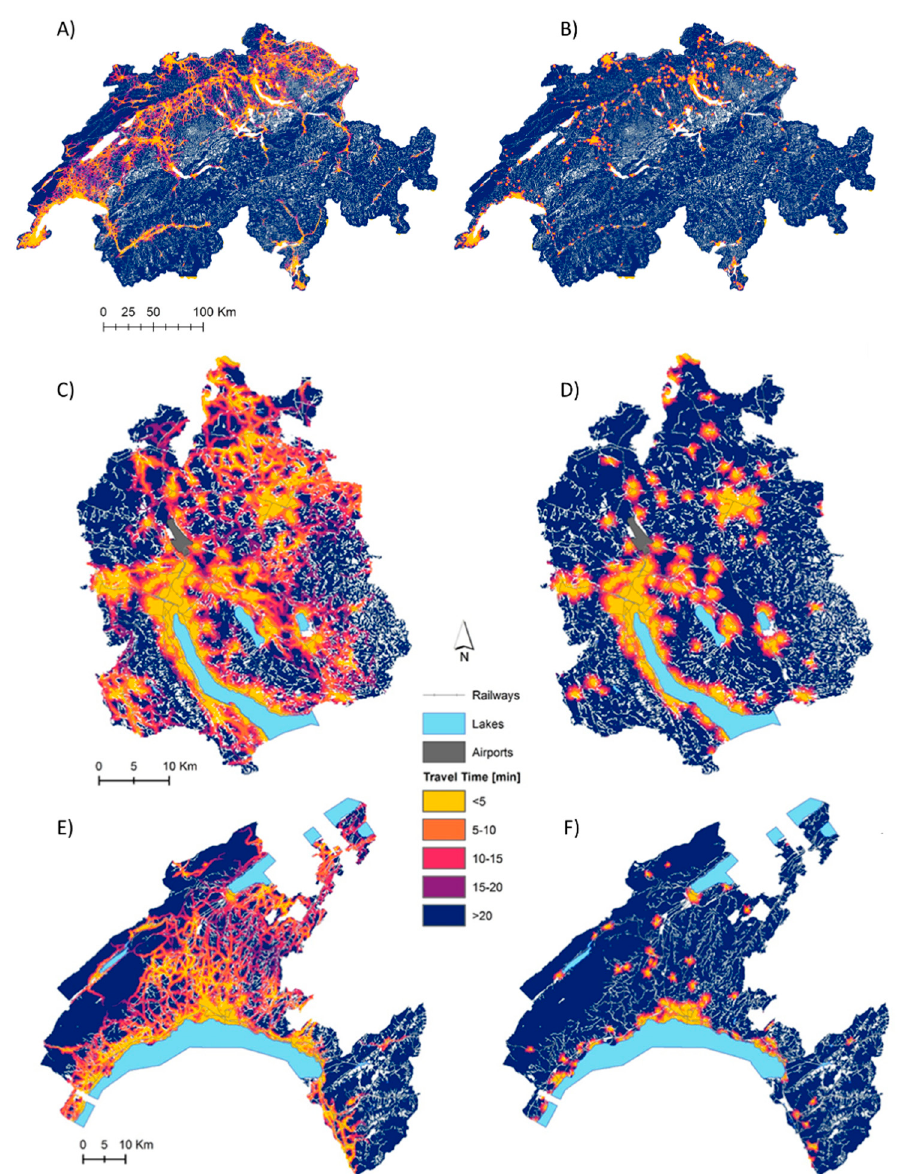
Figure 3. Travel time to reach centroids of urban green spaces, using a walking and motorized model: ( A ) nationally,